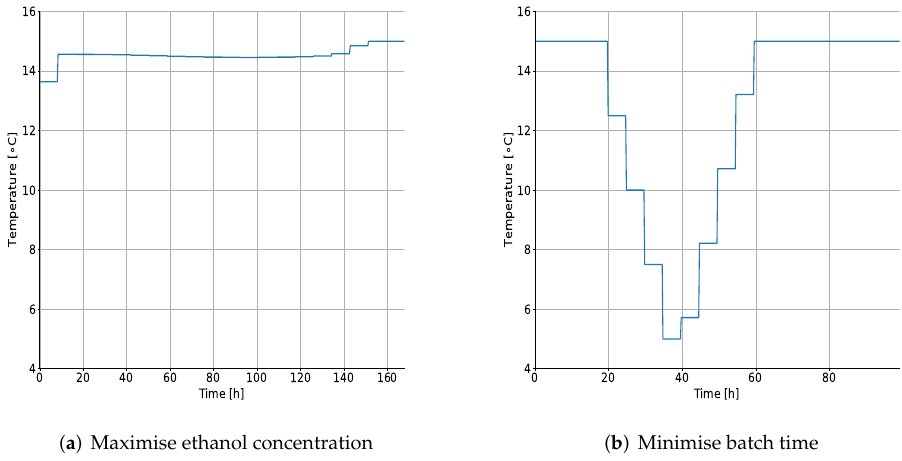
Figure 1. Optimised temperature profiles for the nominal case with two different objectives: max- imising ethanol concentration and minimising batch